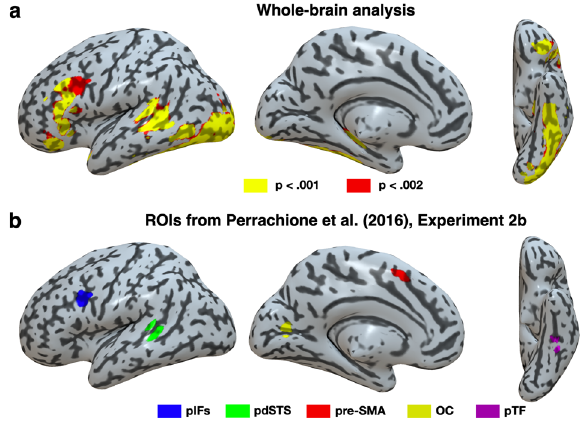
Fig. 4 Whole-brain neural adaptation to words and location of ROIs. a Brain regions more activated for no-adaptation than adaptation blocks in the word adaptation task across the whole brain. b Location of ROIs on lateral and ventral views of an in fl ated rendering of the cortical surface and an axial slice of an MNI normalized brain. pIFs left inferior frontal sulcus, pdSTS left posterior dorsal superior temporal sulcus, pre-SMA left pre-supplementary motor area, OC left occipital cortex, pTF left posterior temporal fusiform